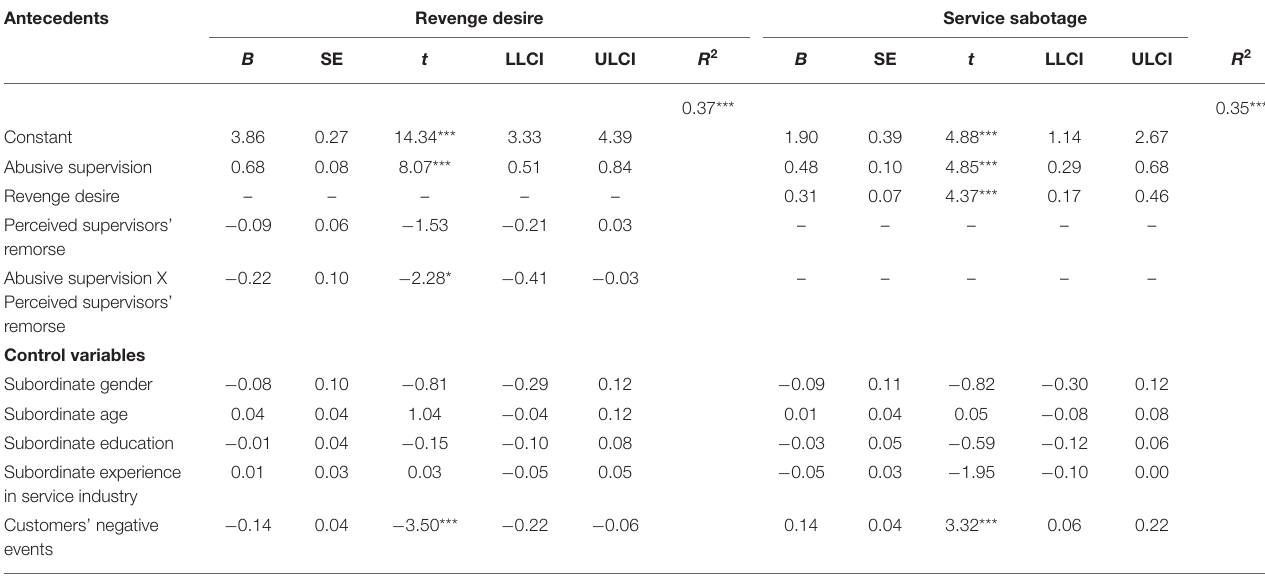
TABLE 3 | Results of the moderated-mediation model analysis. Antecedents